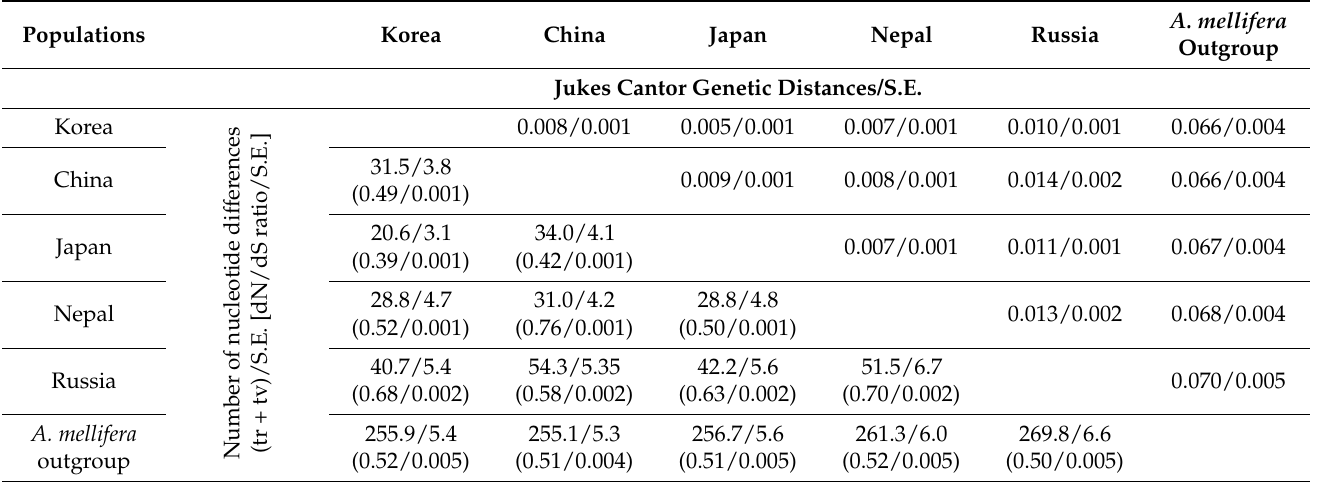
Table 2. The Jukes–Cantor genetic distances above the diagonal, the number of nucleotide differences (transitions + transversions), and the ratio of nonsynonymous to synonymous substitutions (dN/dS) below the diagonal between populations of A. cerana and outgroup A. mellifera based on the VG gene sequences and their standard error S.E.